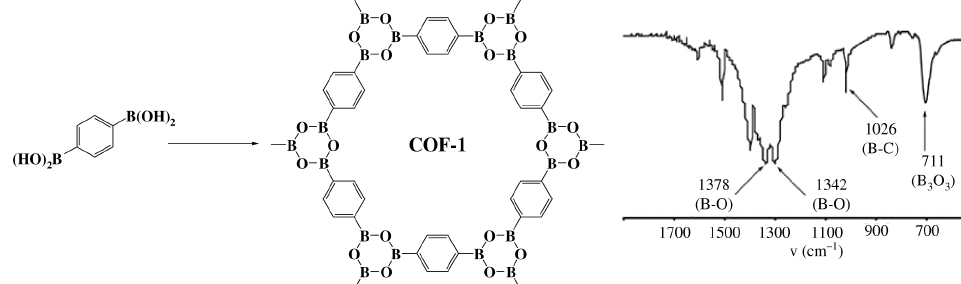
Figure 1: Condensation reactions of boronic acids used to produce COF-1 and the FT-IR spectra of